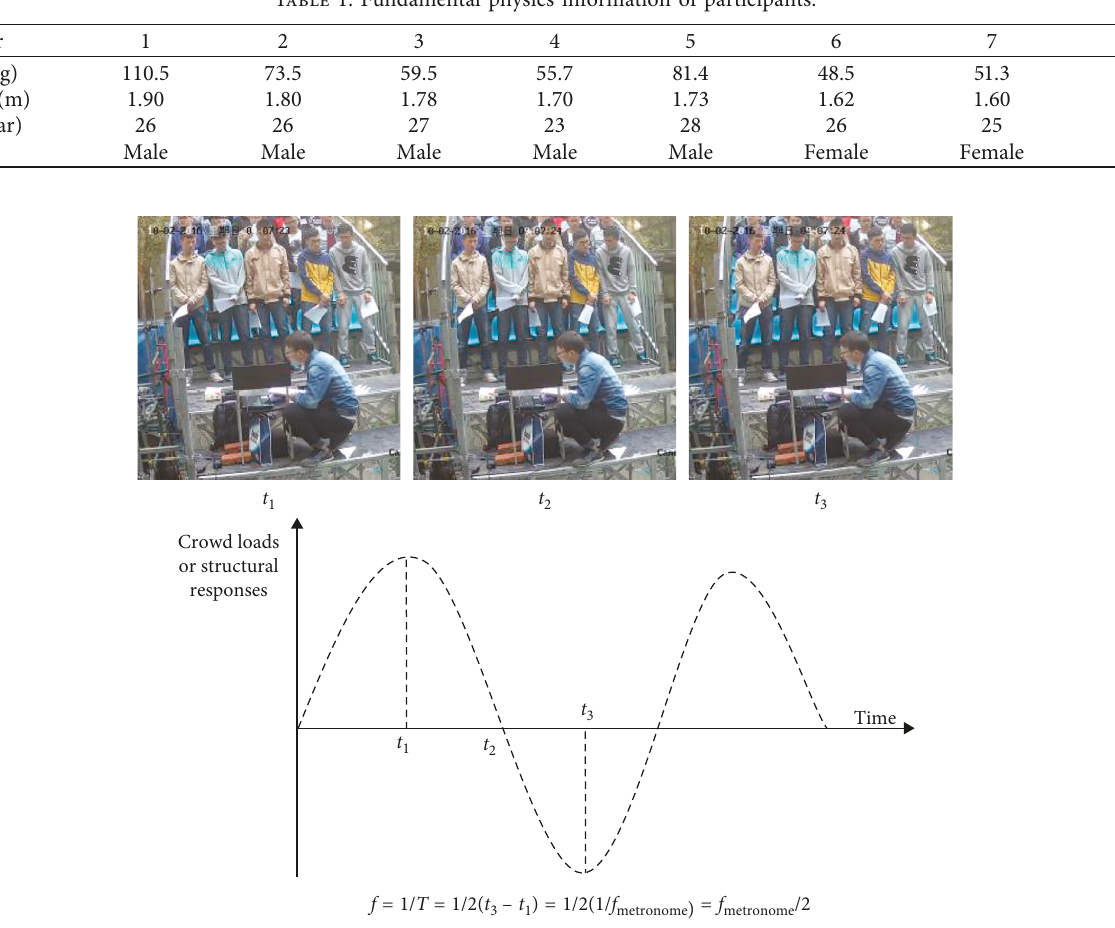
Figure 1: The relationship between metronome frequency and crowd swaying frequency.